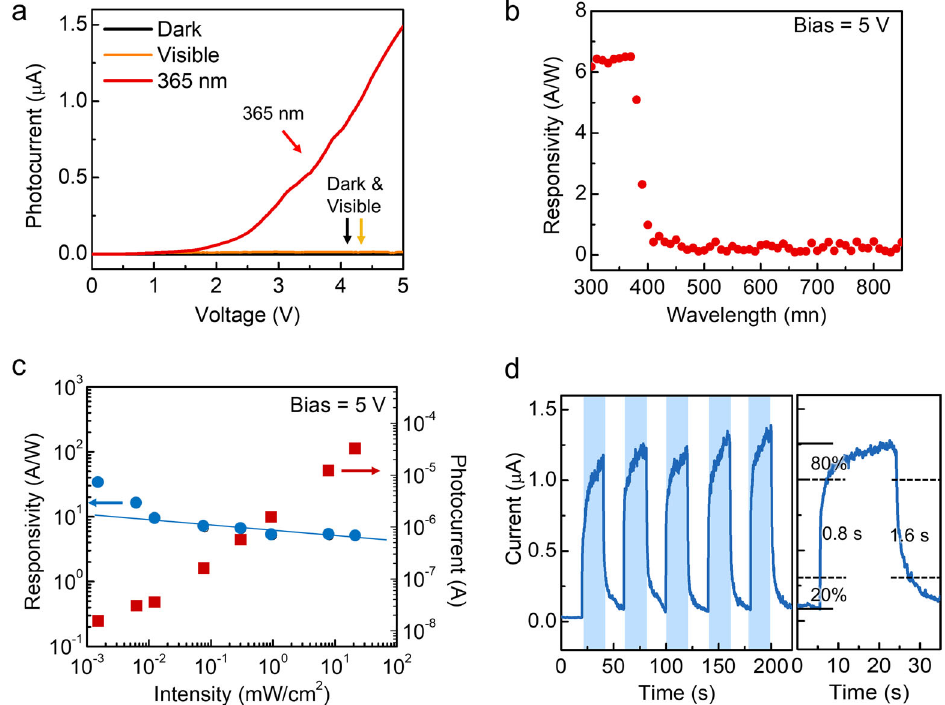
Fig. 2 a The IV characteristic curves of the NW PD under dark, UV, and visible illumination. b The responsivity of the PD at different wavelengths. c The dependence of the device responsivity on the incident power. d The left panel shows the time-domain photoresponse alternating between on and off states for fi ve cycles at 5 V. The right panel presents the analysis of the response and recovery